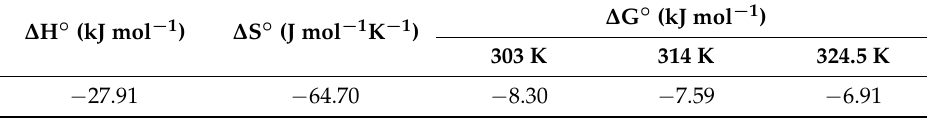
Table 4. Thermodynamic parameters for MB adsorption onto PPL and MPPL.